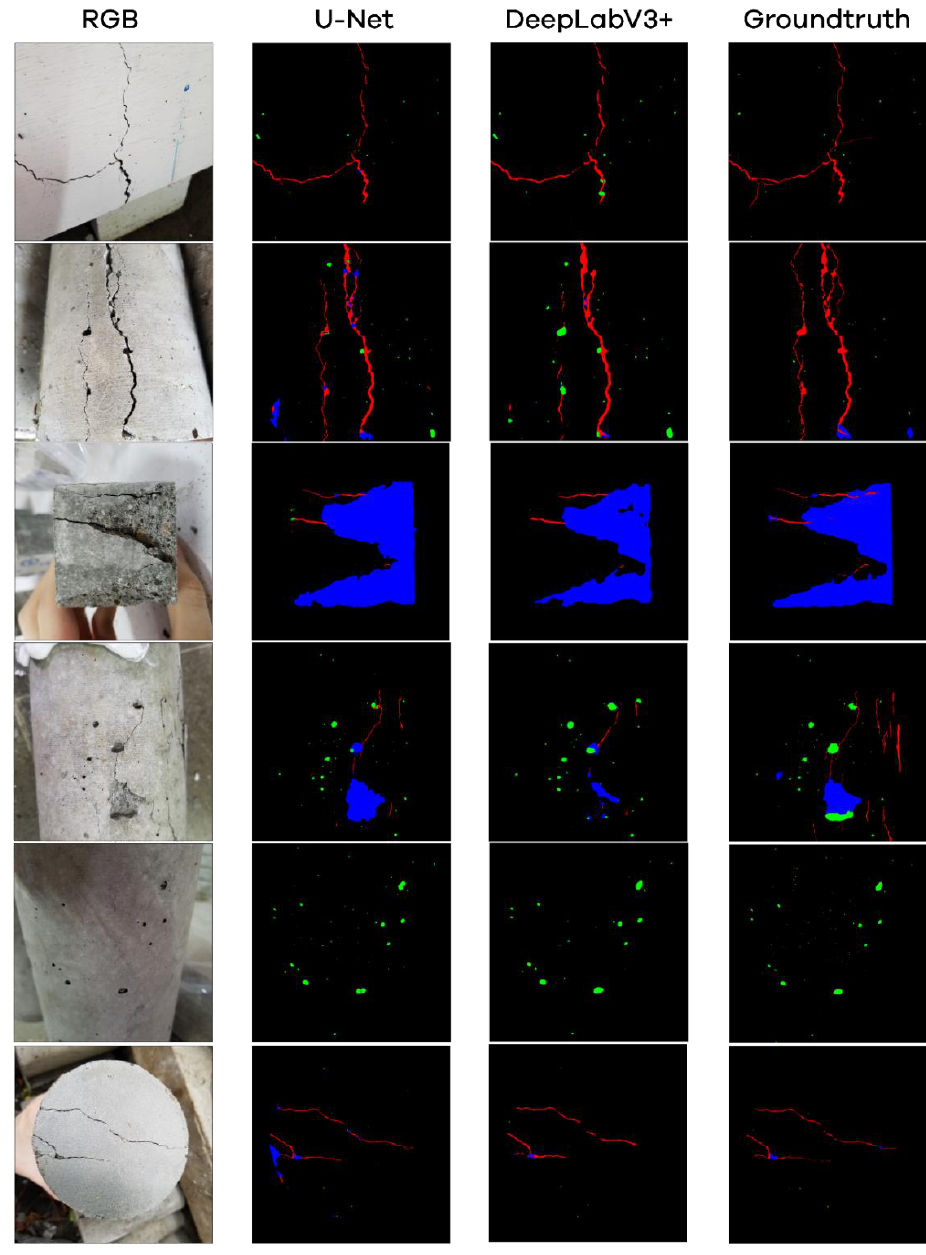
Figure 14. Models’ prediction on validation data.